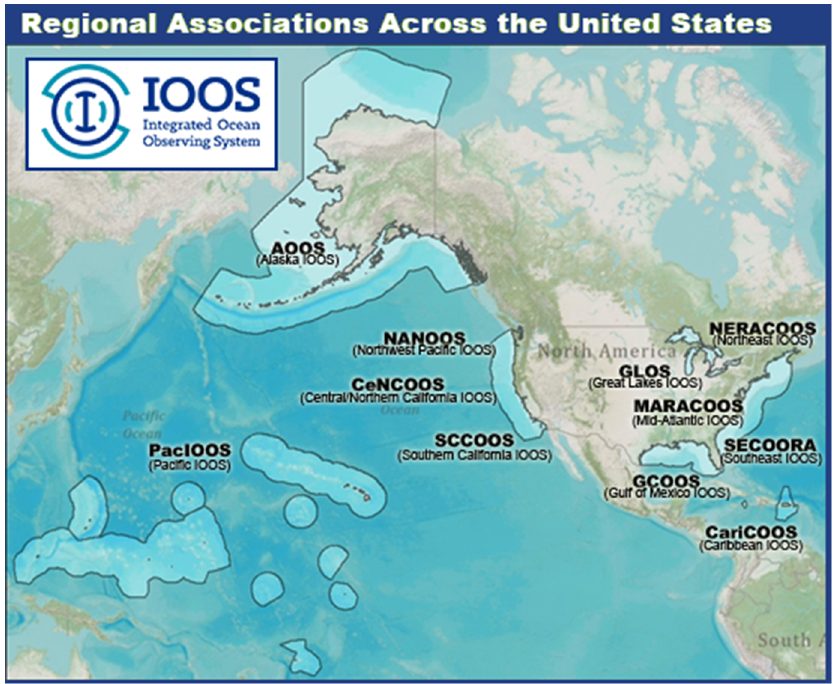
Figure 1. IOOS is a NOAA ‐ led partnership between 11 Regional Associations (shown here) and 17 federal agencies with a wide range of observed and modeled data products distributed via a system of web service providers and a centralized catalog of